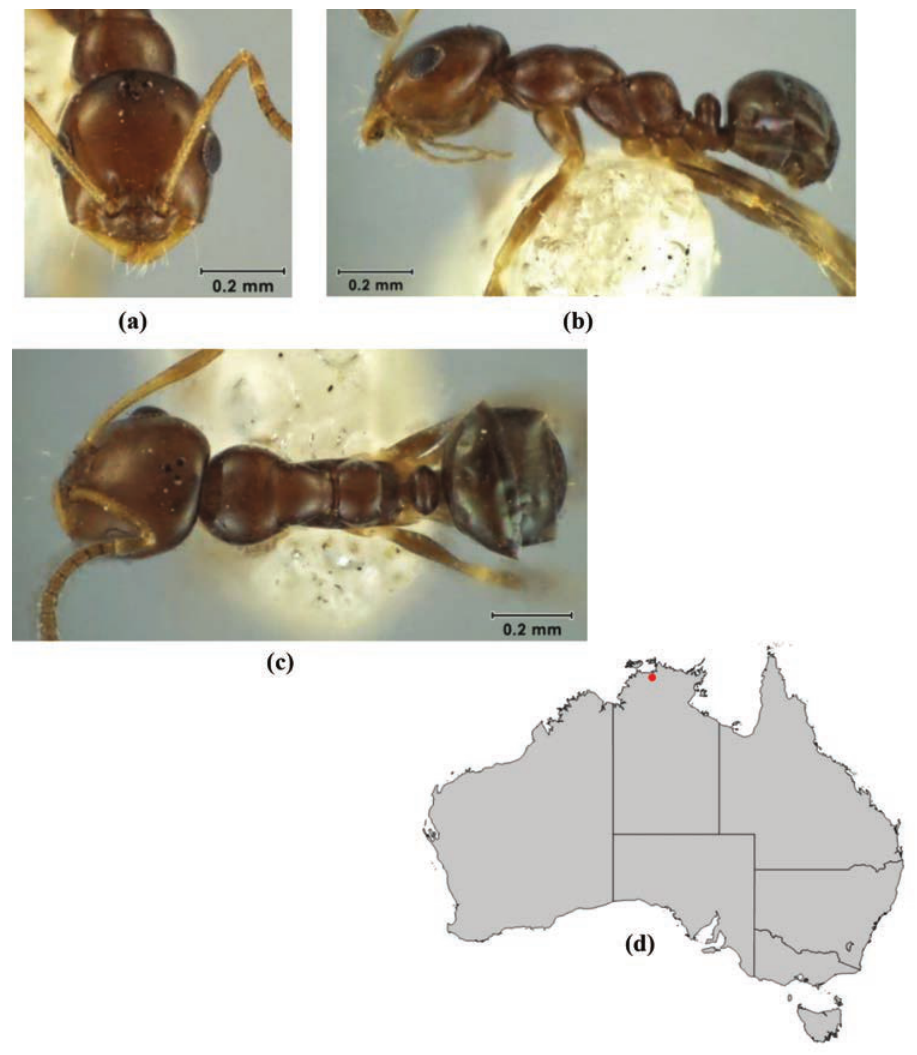
Figure 30. Melophorus argus sp. n.: minor worker holotype (ANIC32-066597–top ant) frons ( a ), profile ( b ) and dorsum ( c ); distribution map for the species ( d